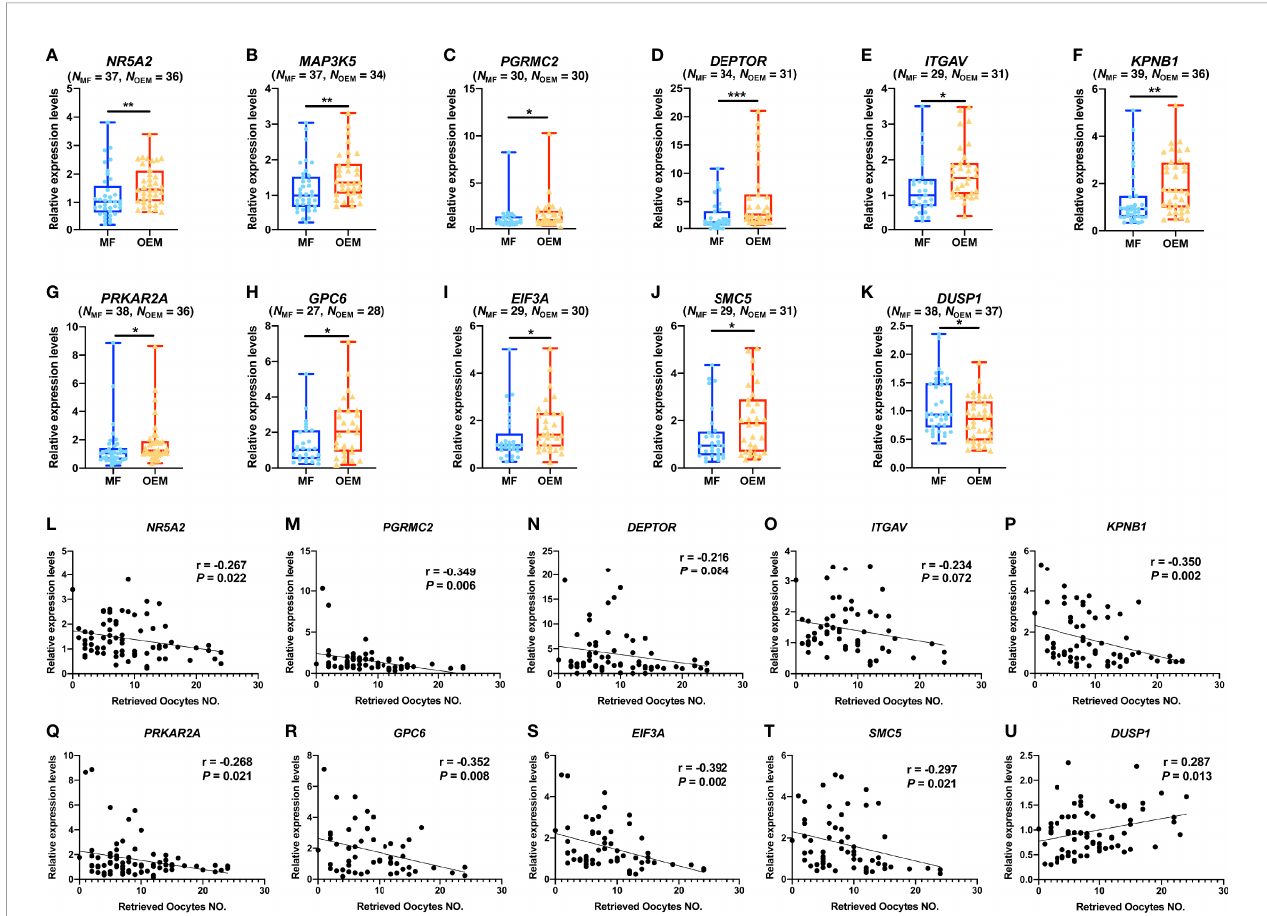
FIGURE 4 | OEM-associated DEGs validation and correlation analysis with retrieved oocyte numbers. (A – K) Validation of selected DEGs by expanding clinical samples through real-time quantitative polymerase chain reaction (qPCR) ampli fi cation demonstrate signi fi cant differences between the OEM and MF groups. (N, sample size). (L – U) Pearson correlation analyses between relative expression levels of the validated DEGs and the retrieved oocyte numbers (r, Pearson correlation coef fi cient). (* p < 0.05, ** p < 0.01, *** p <